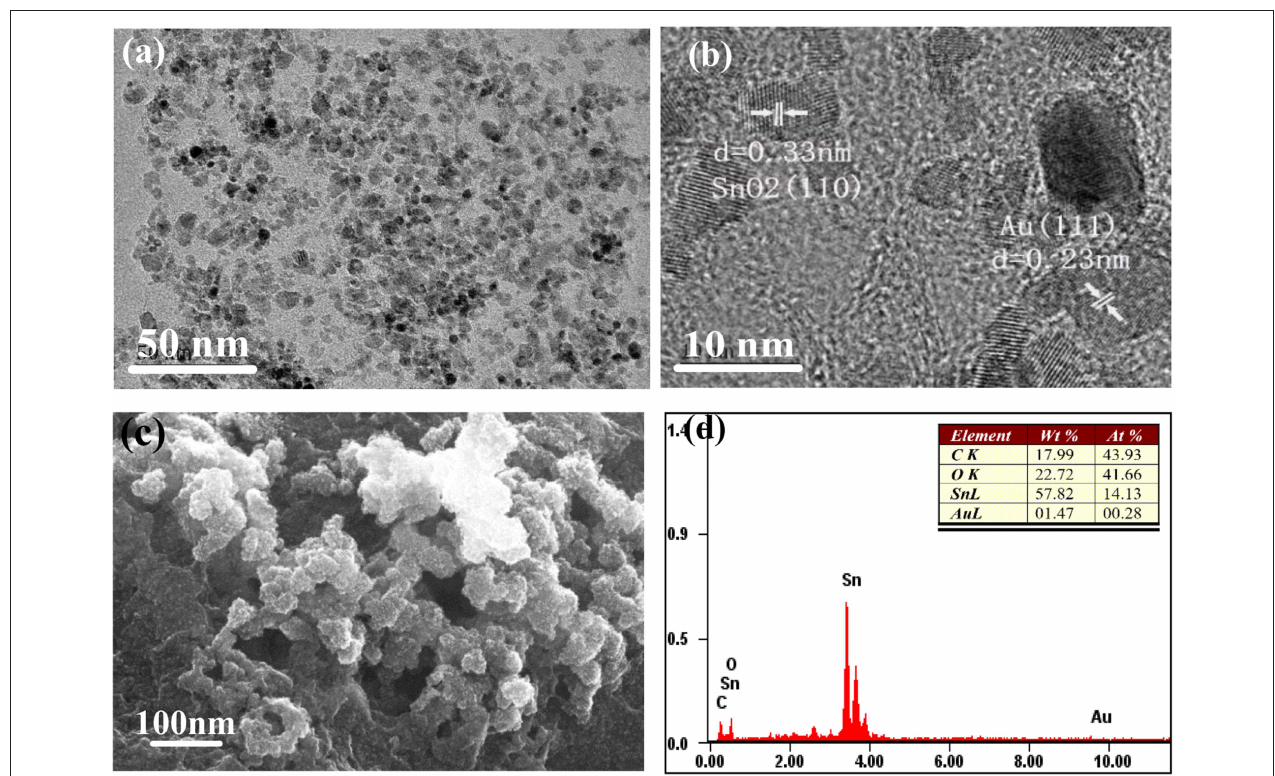
FIGURE 6 | (a) TEM, (b) HRTEM, (c) SEM, and (d) EDS of AuNPs-SnO 2 -rGO.